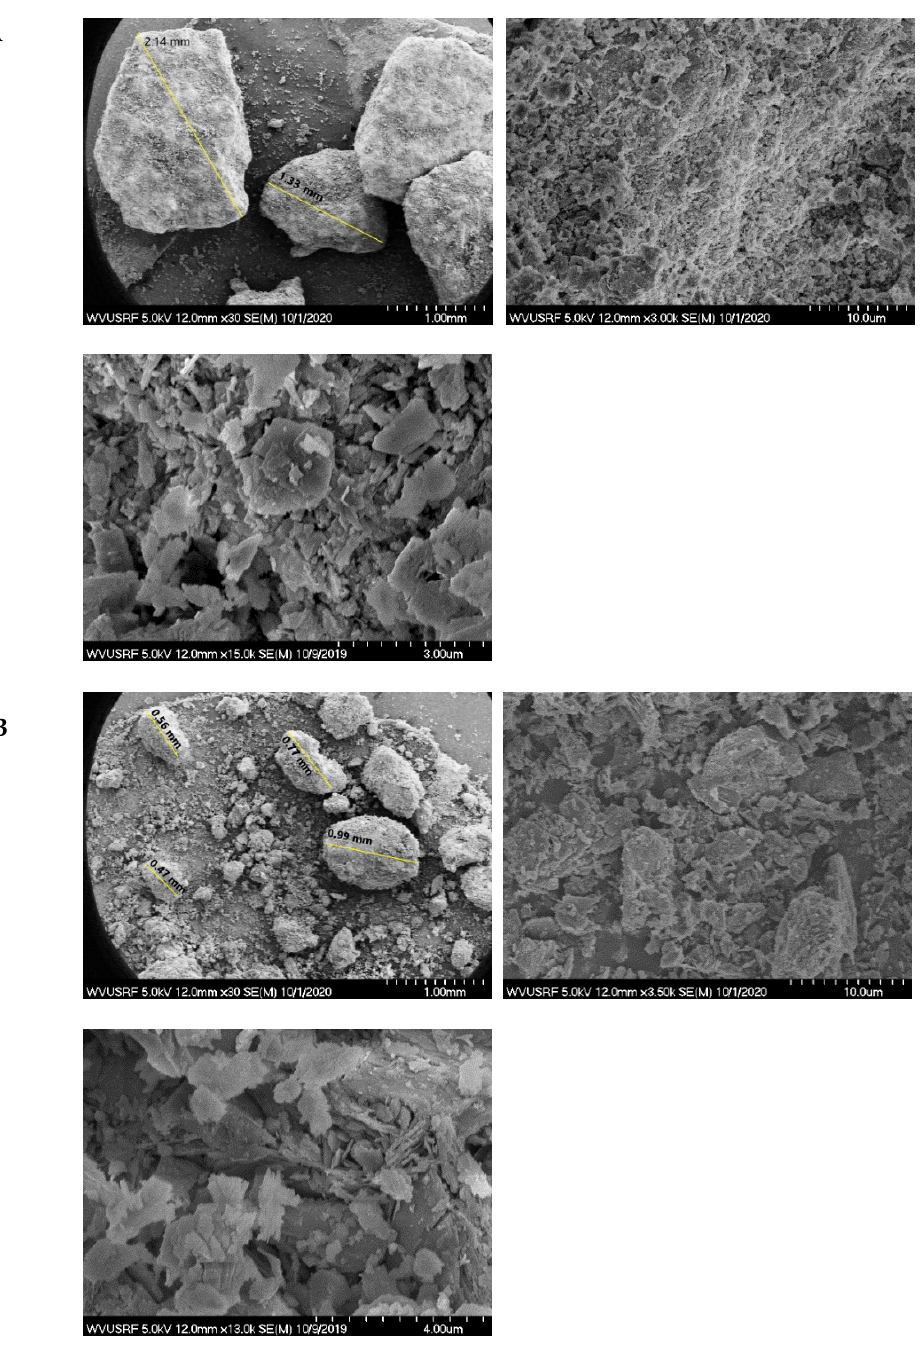
area, as seen in Figure 2. EDX spectrums of three zeolite samples are presented in Figure 3. All three samples possess a similar EDX pattern, which indicates the presence of Si, O, and Al, as suggested by the main peaks. Compared to the coarse and middle-sized zeolite samples, the EDX pattern of the finest zeolite sample (12 µ m) displays considerably high intensities for all element peaks. In addition to Si, Al, and O, a portion of Na was also detected. The findings obtained from the EDX, XRF, and XRD analyses complete and support each other. The carbon peak seen in the EDX spectrum is due to the carbon tape substrate used during sample preparation.